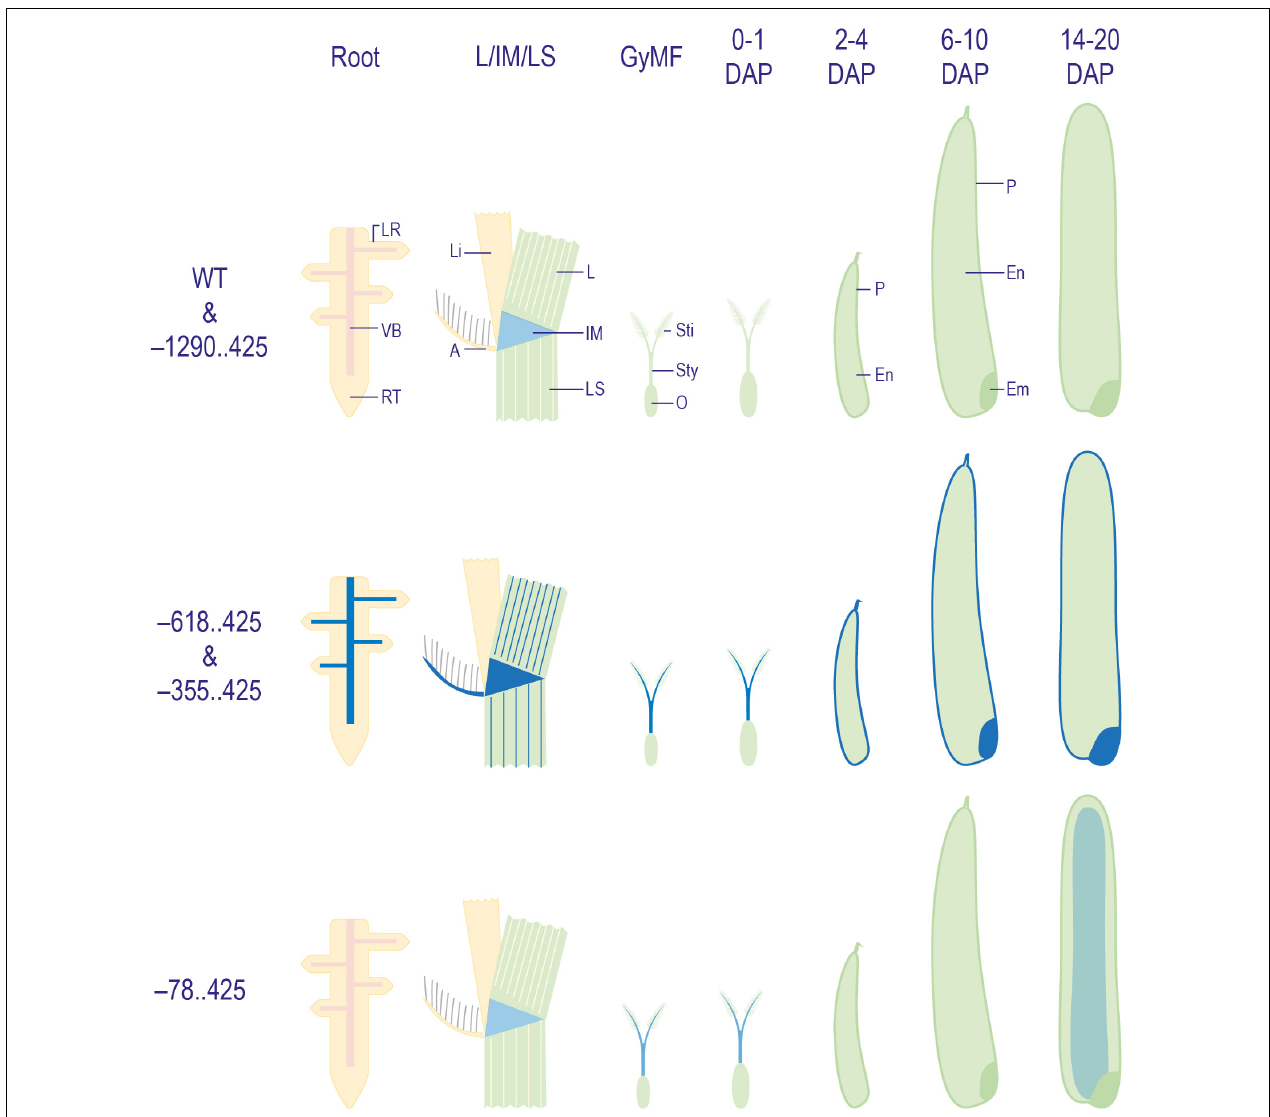
FIGURE 8 | Diagrammatic representation of GUS expression patterns obtained in WT and transgenic plant tissues. Illustrations depicting a summary of patterns of GUS expression obtained in WT, and –1290..425, –618..425, –355..425, and –78..425 transgenic plants. Here, GyMF, gynoecium of mature floret; DAP, days